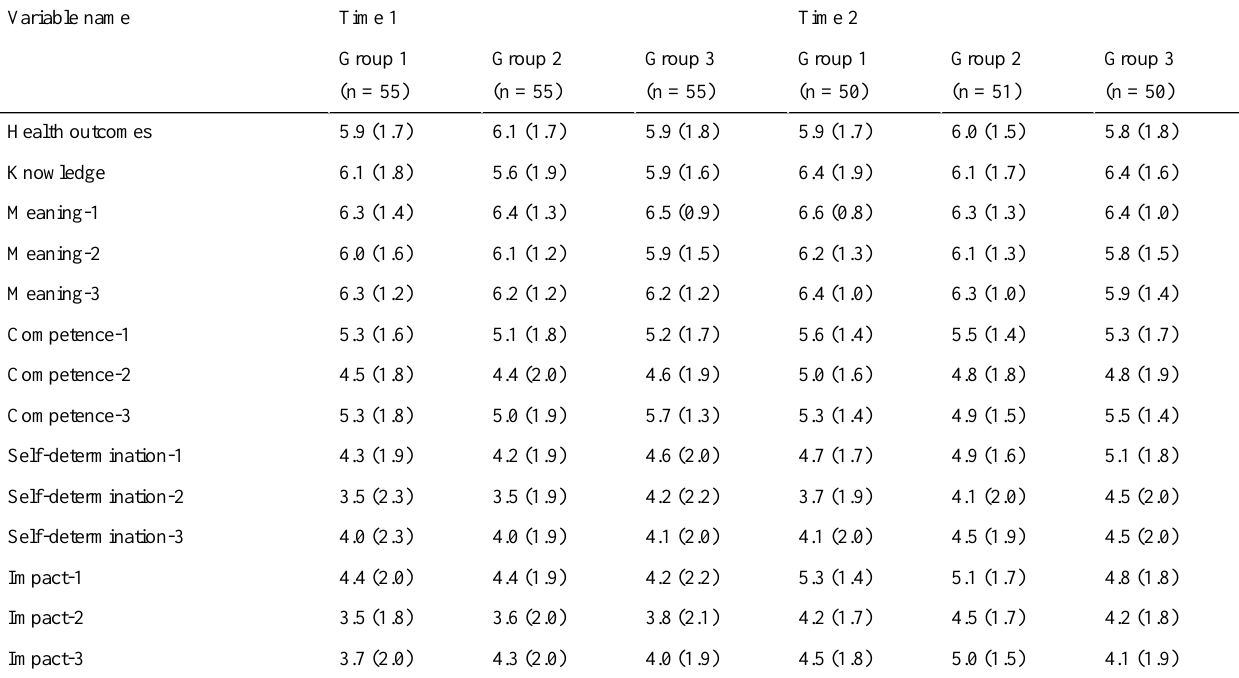
Table 2. Descriptive statistics (mean, SD) for experimental measures for study groups 1–3 at time 1 (pretest) and time 2 (posttest) a